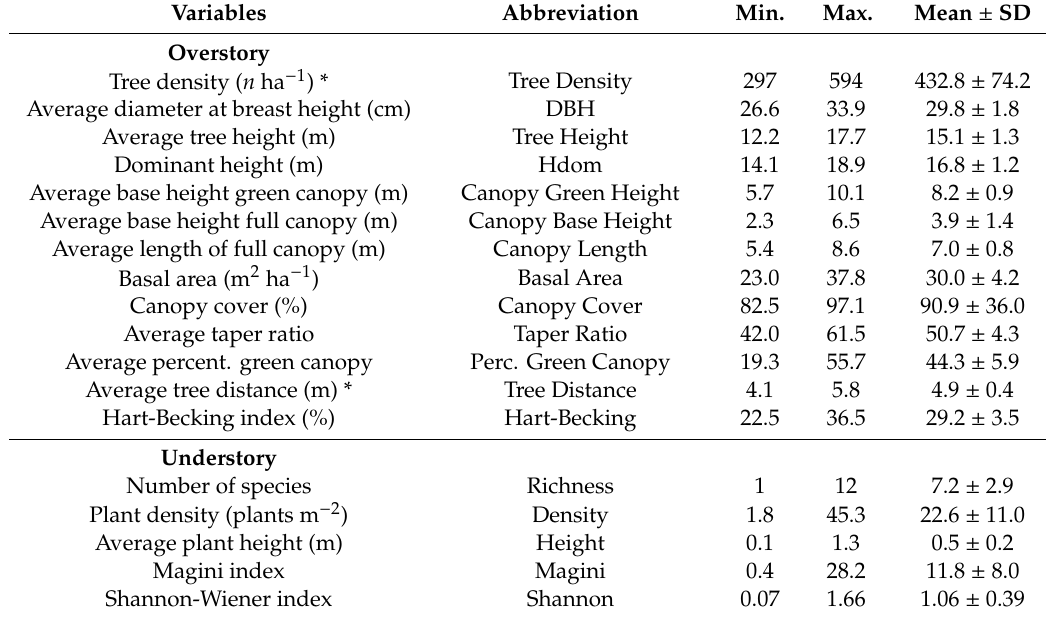
Table 1. List of 13 overstory variables and five understory variables. Tree density and Average tree distance were not considered for model building but are presented here for additional information about stand and vegetation